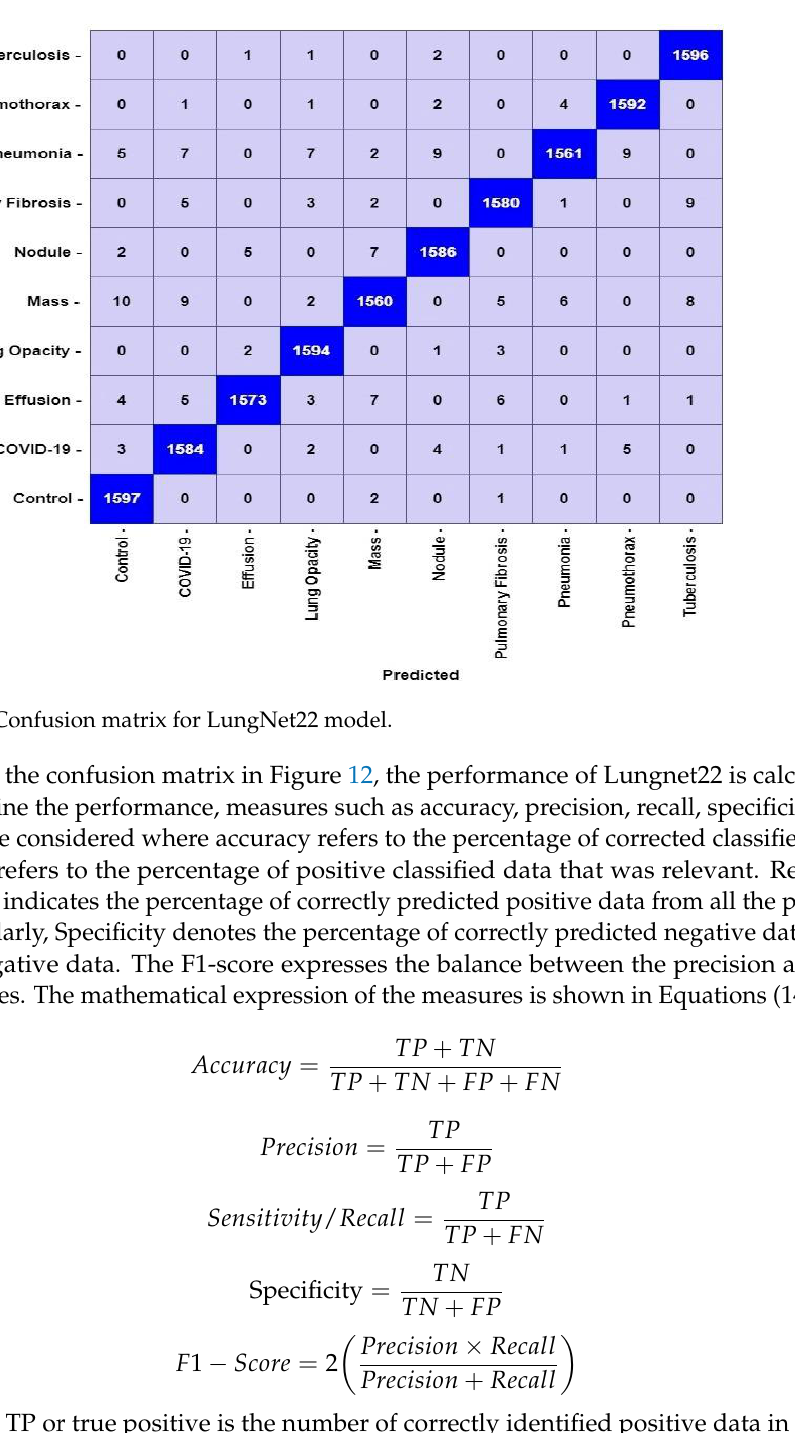
( b ) Figure 11. The ( a ) Accuracy and ( b ) Loss of the proposed model LungNet22 for 300 epochs using ‘Adam’ optimizer with learning rate 0.000001.